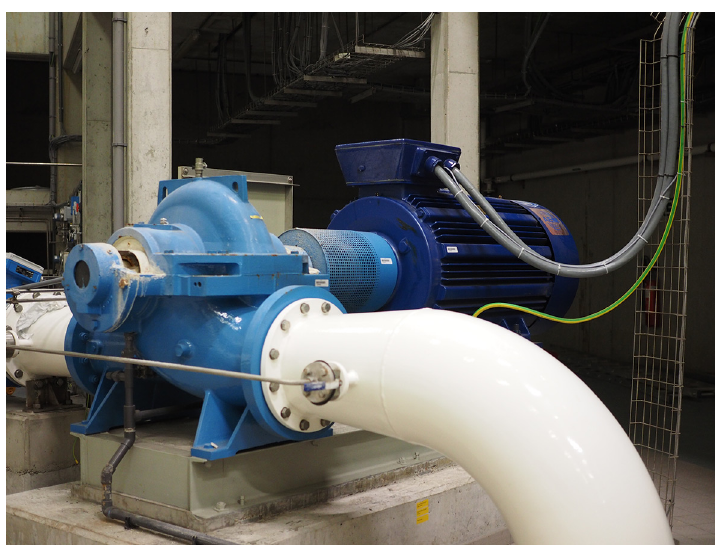
Fig. 12. – Typical example of continuous operation: pump for urban drinking water supply.